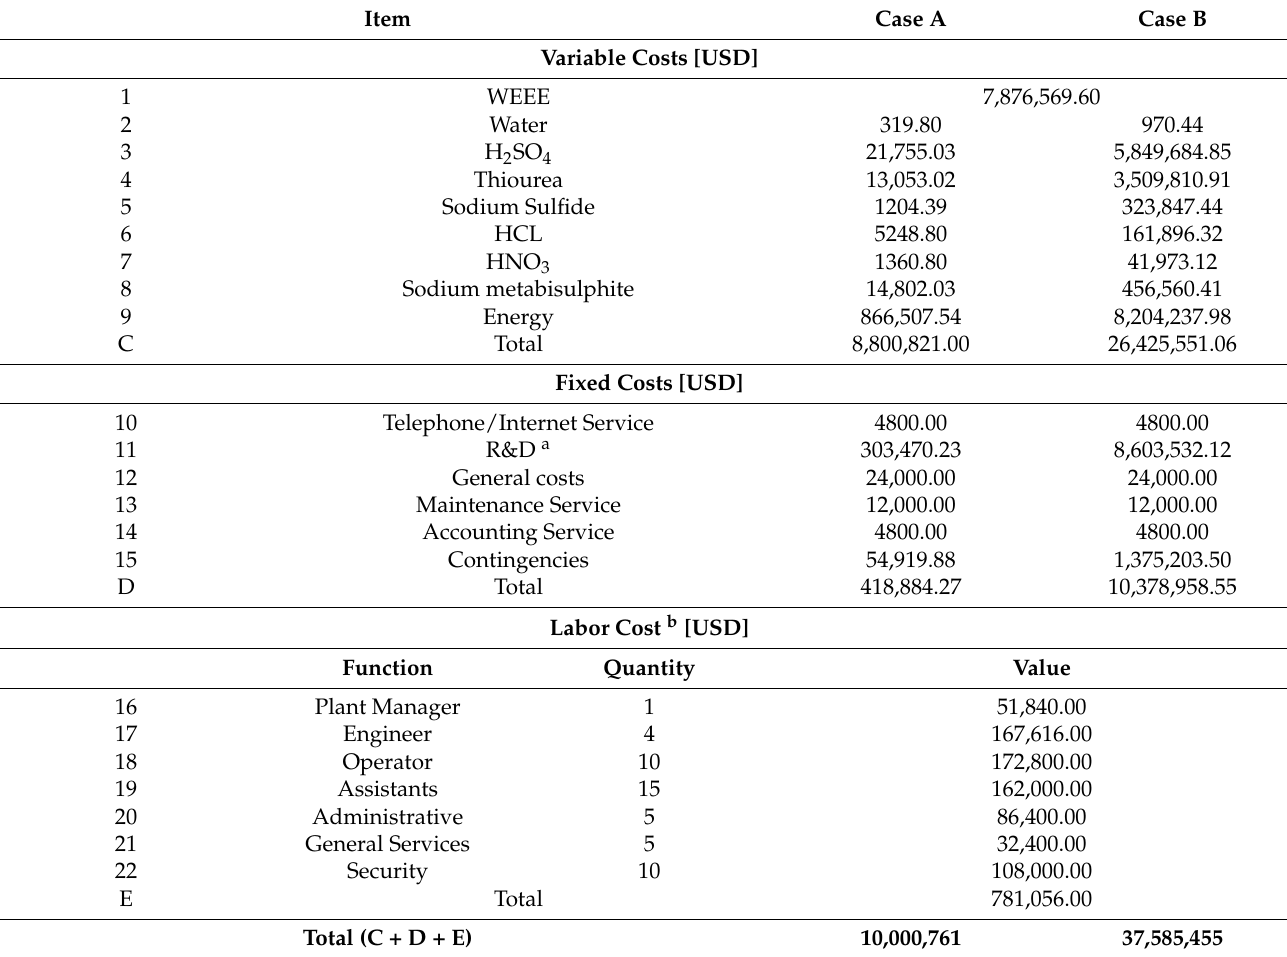
Table 7. Total Annual Opex for the Cases A and